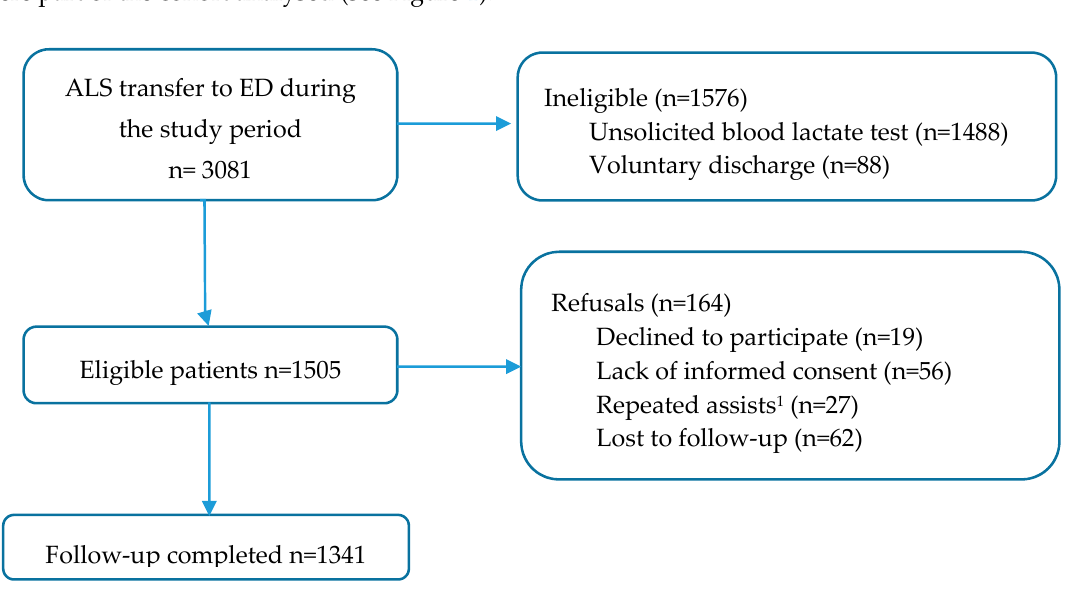
Table 1. Demographic, prehospital and hospital clinical outcomes.